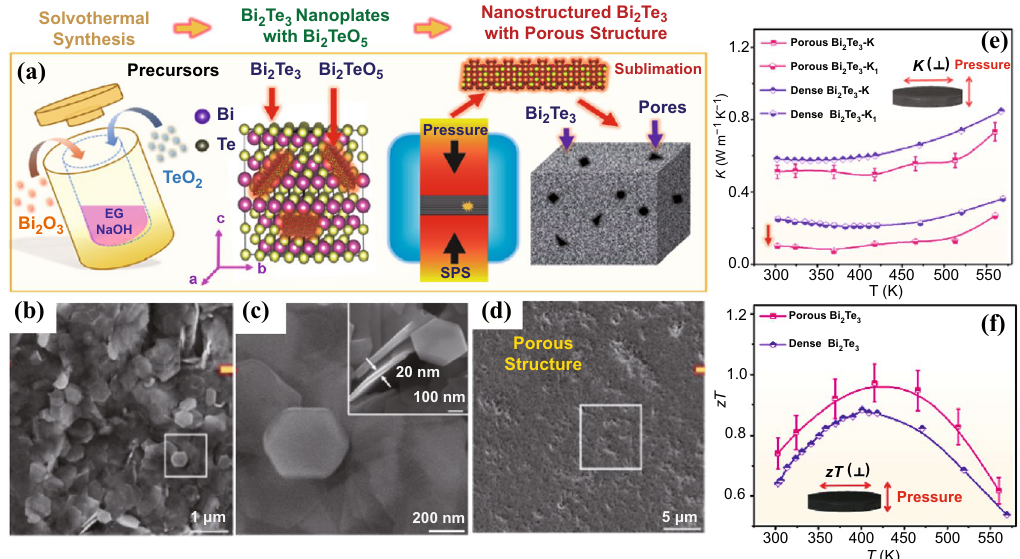
Fig. 14 a Illustration of the solvothermal synthesis of Bi 2 Te 3 nanoplates followed by SPS to fabricate a porous nanostructured Bi 2 Te 3 pellet. SEM images of b, c the as-synthesized Bi 2 Te 3 nanoplates and d the as-sintered nanostructured porous Bi 2 Te 3 . Temperature dependence of e κ and κ L , f ZT of the as-sintered nanostructured porous Bi 2 Te 3 pellet compared with dense nanostructured Bi 2 Te 3 . Adapted with permission from Ref.